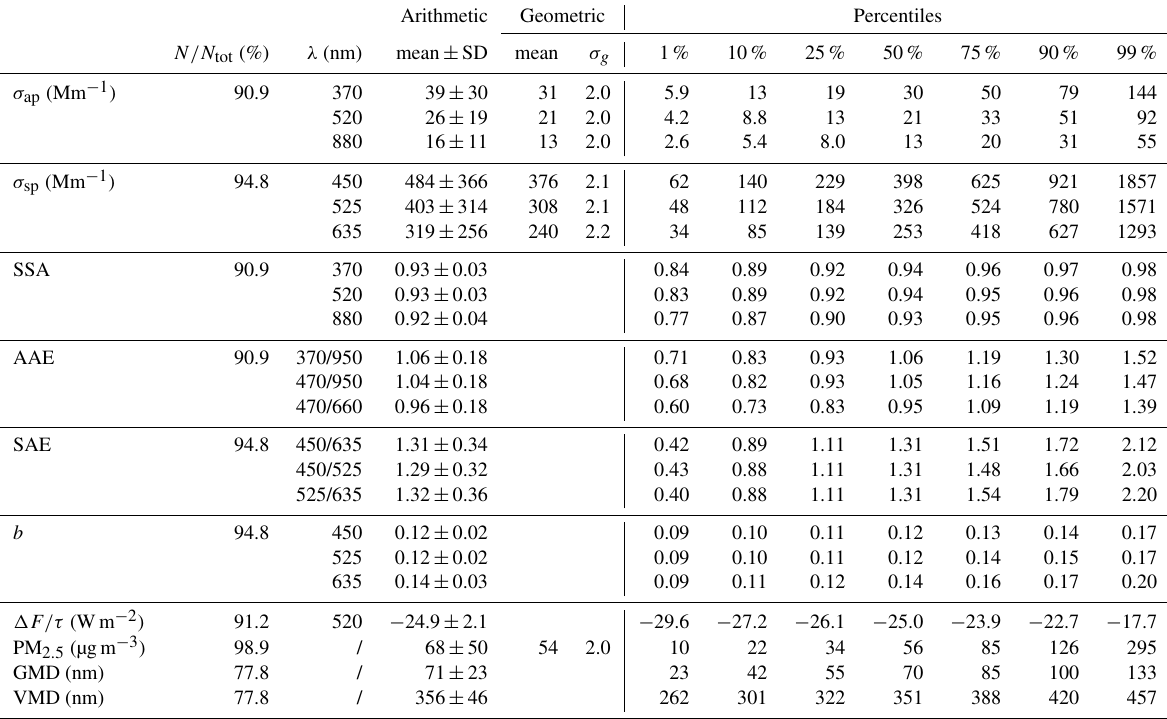
Table 1. Statistical summary of aerosol optical properties and associated supporting parameters measured at SORPES, Nanjing, in July 2013– May 2015. N/N tot : fraction of hours with valid observations, σ ap : absorption coefficient, σ sp : scattering coefficient, SSA: single-scattering albedo, AAE: Ångström exponent of absorption, SAE: Ångström exponent of scattering, b : backscatter fraction, (cid:49)F/τ : radiative forcing efficiency, PM 2 . 5 : mass concentration of particles smaller than 2.5µm aerodynamic diameter, GMD: geometric mean diameter, and VMD: volume mean